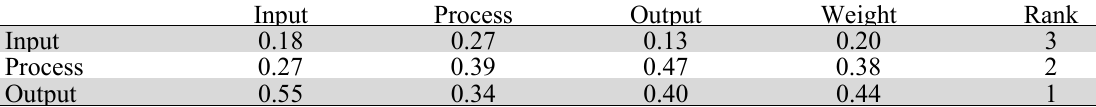
Normalized Matrix and weight of factor production to goal ICA